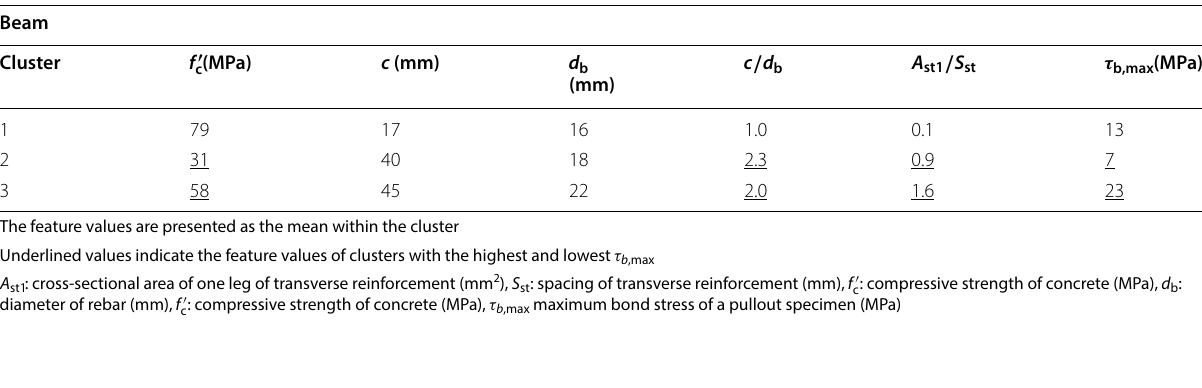
Table 5 Feature values of each cluster (beam data